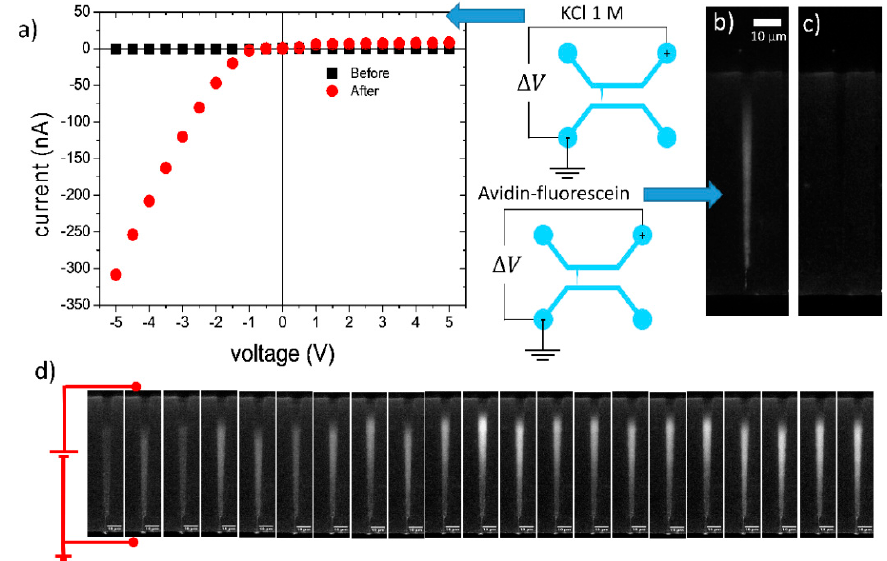
Figure 3. Accumulation experiments in devices functionalized with antibodies. ( a ) Current-voltage curve of a micro / nanofluidic device, filled with 1 M KCl, measured before (black squares), and after (red circles) the junction gap breakdown procedure. ( b , c ) Epifluorescence microscopy images of the funnel after 10 min at − 10 V (b) and 10 V (c), with the cis -microchannel filled with avidin–fluorescein (12 pg / mL). ( d ) Sequence of epifluorescence images acquired at time intervals of 30 s during the application of a constant bias of − 10 V for 10 min with the cis -microchannel filled by 30 pg / mL avidin–fluorescein.